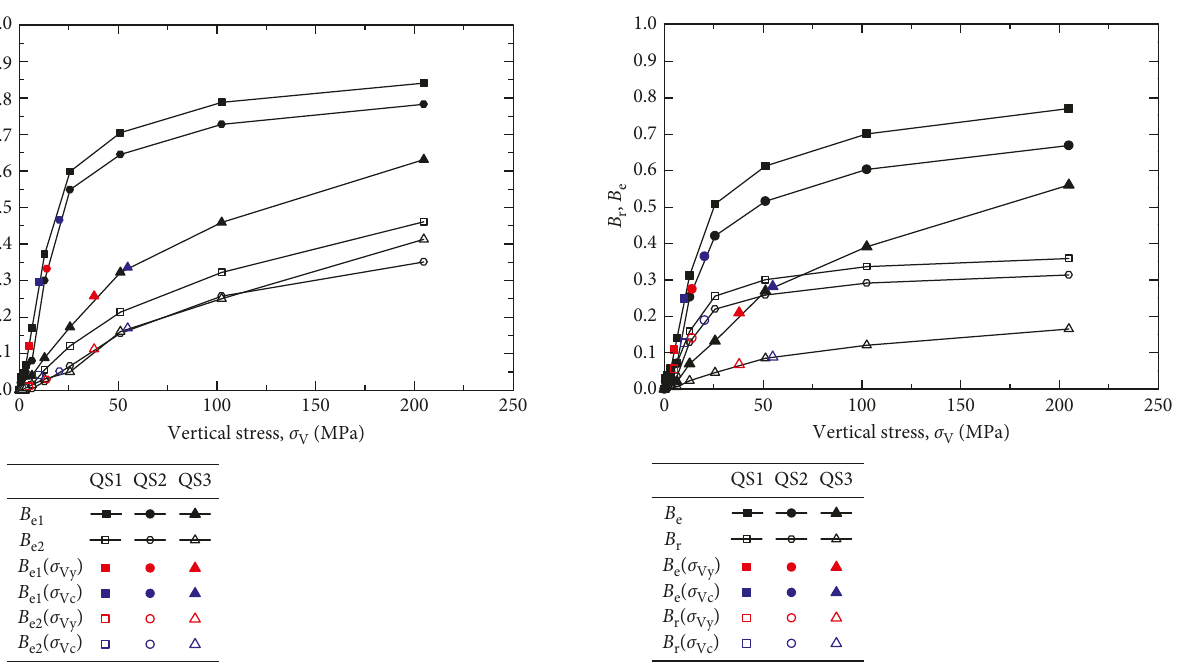
V and B e or B r